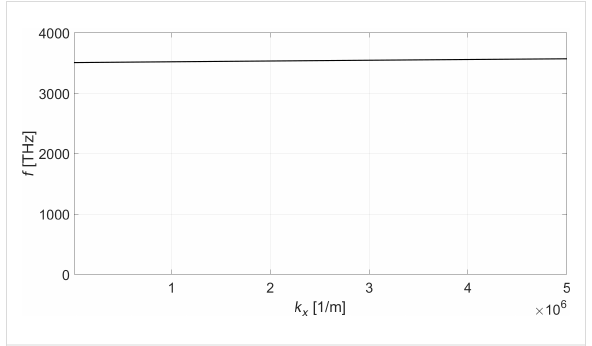
Figure 3: Dispersion relation for the optical phonon modes of single- layer